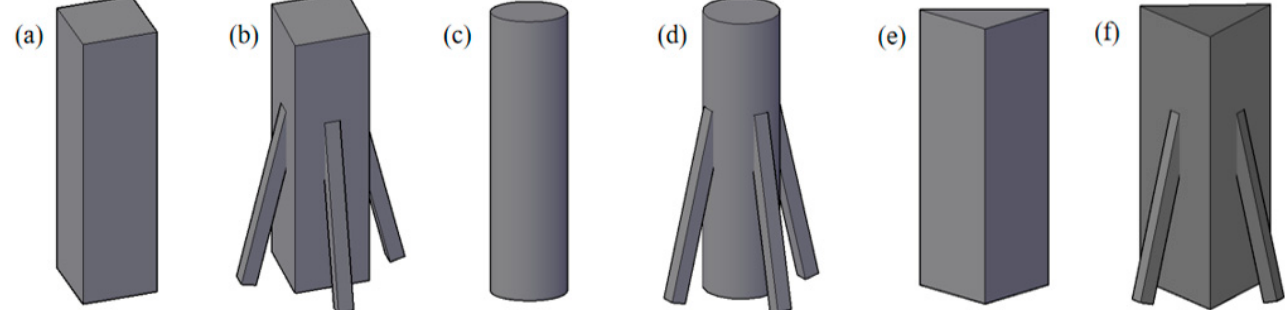
Figure 12. Baffle group type, ( a ) Z1; ( b ) Z2; ( c ) Z3; ( d ) Z4; ( e ) Z5; ( f ) Z6.